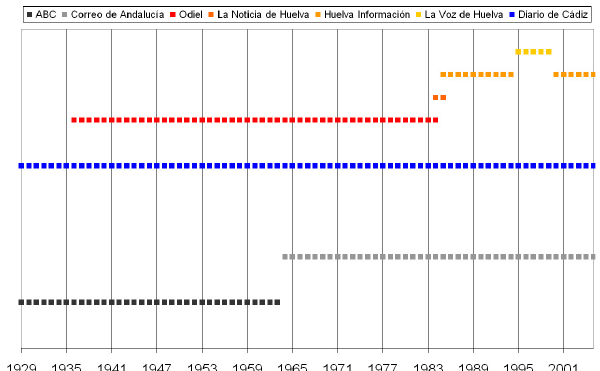
Fig. 1. Newspapers used in the review and the period they covered. Regional press is represented in gray scale and local press in colour